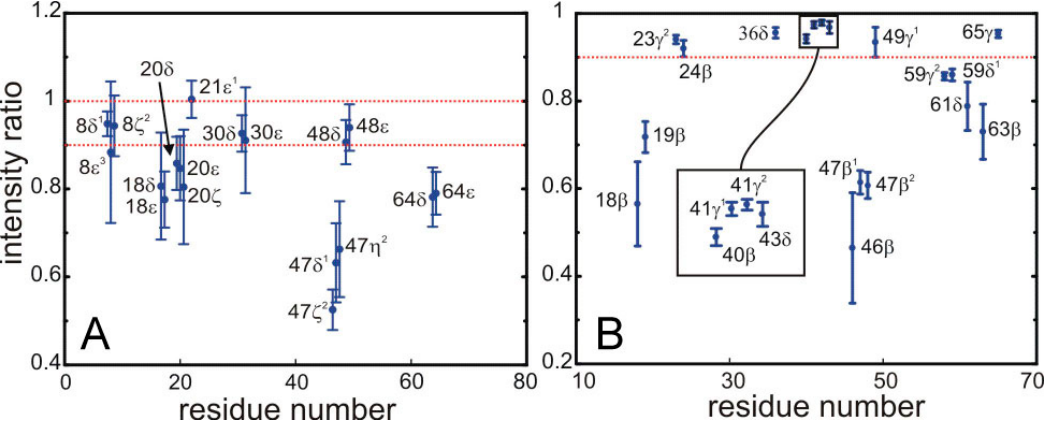
Figure 5. Saturation of the signals from for the 13 C bonded aromatic ( A ) and aliphatic ( B ) protons of side-chains in SH3 by the sequence employed for the selective saturation transfer. The ratio of intensities in the HSQC with and without the selective saturation scheme is plotted along the y -axis. ( A ) The left panel shows the ring aromatics of W8, Y18, F20, H21, F30, W47, Y48, Y64; and ( B ) the right panel the aliphatic protons of the side chains of Y18, N19, T23, A24, L36, A40, V41, K43, N46, W47, I59, P61, N63, V65.